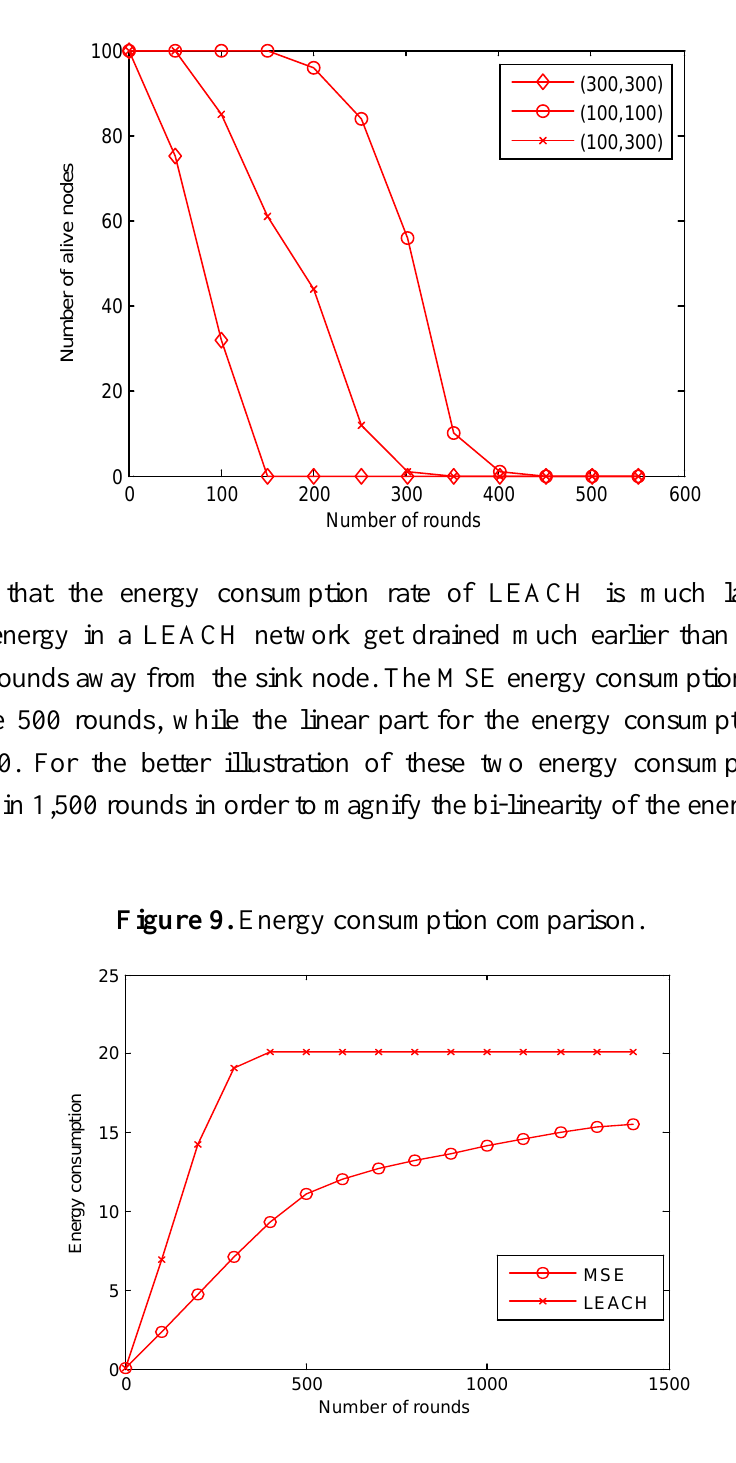
Figure 8. Influence on sink node locations.